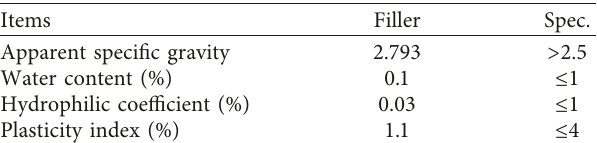
Table 5: Physical properties of fillers.